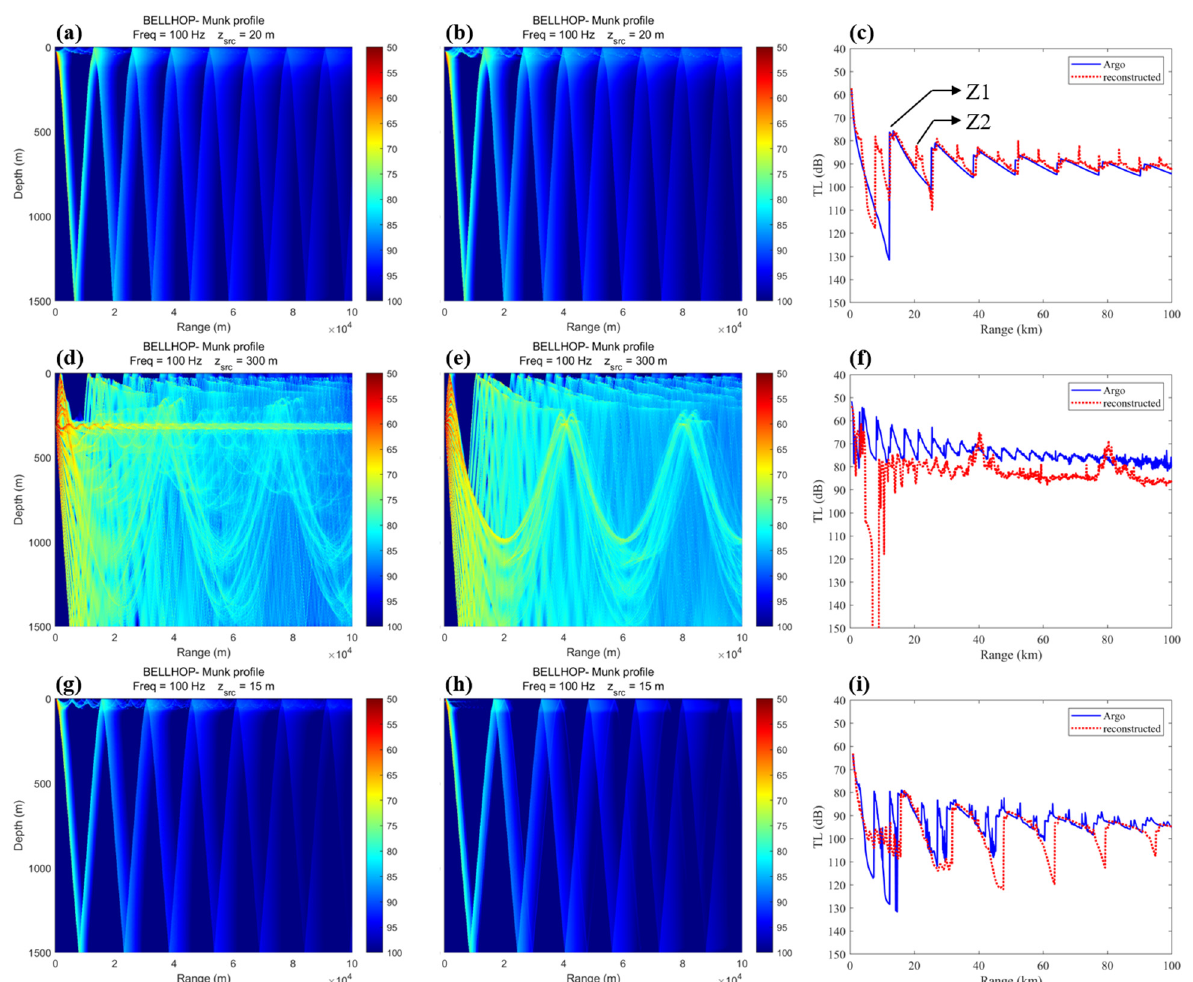
Figure 9. The sound fields with the Argo SSP (left column) and reconstructed SSP (middle column) in Areas ( a , b ) A, ( d , e ) B, and ( g , h ) C, with the SD of 20 m, 300 m, and 15 m, respectively. The TL comparison curves in Areas ( c ) A, ( f ) B, and ( i ) C, with the RD of 50 m, 300 m, and 50 m, respectively.